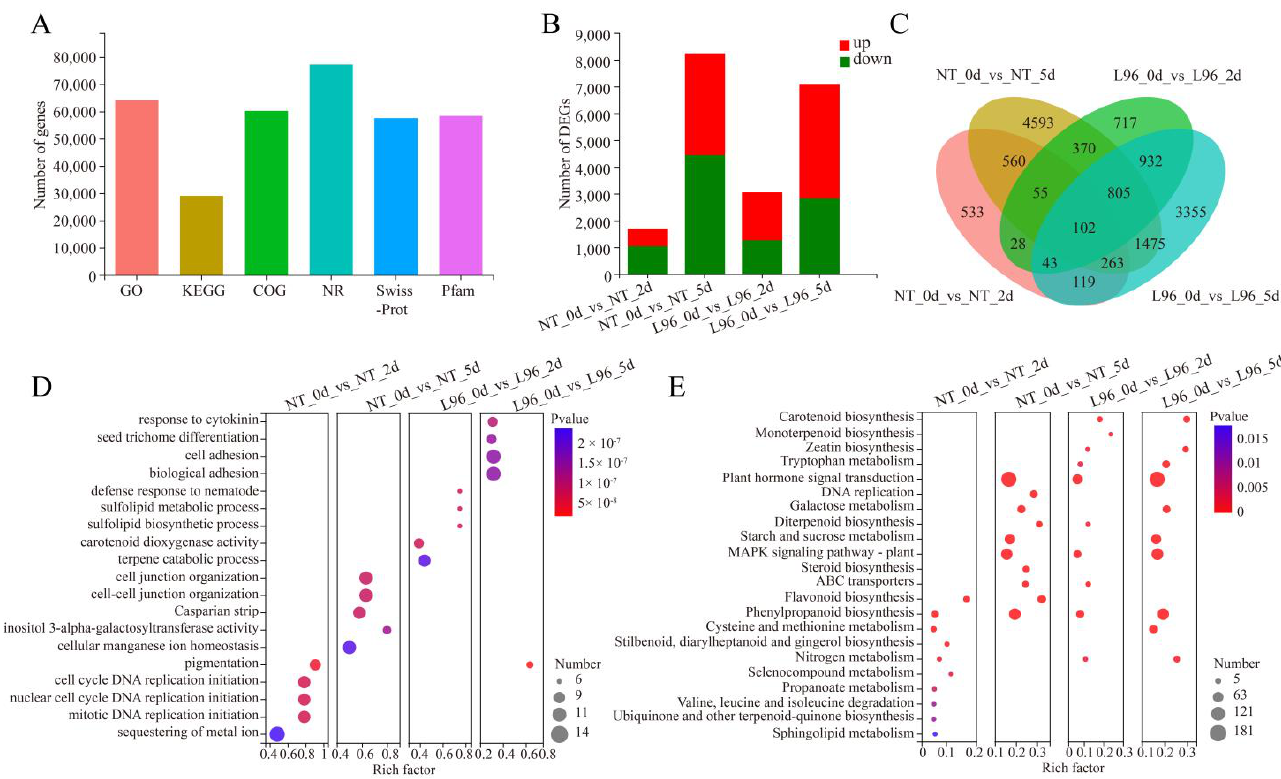
Figure 2. Transcriptome annotation and functional enrichment of DEGs. ( A ) Functional annotation of genes in GO, KEGG, COG, NR, Swiss-Prot, and Pfam databases. ( B ) Differential expression analysis of samples under salt stress. ( C ) Venn analysis of DEGs. ( D ) GO enrichment analysis of DEGs. ( E ) KEGG enrichment analysis of DEGs.